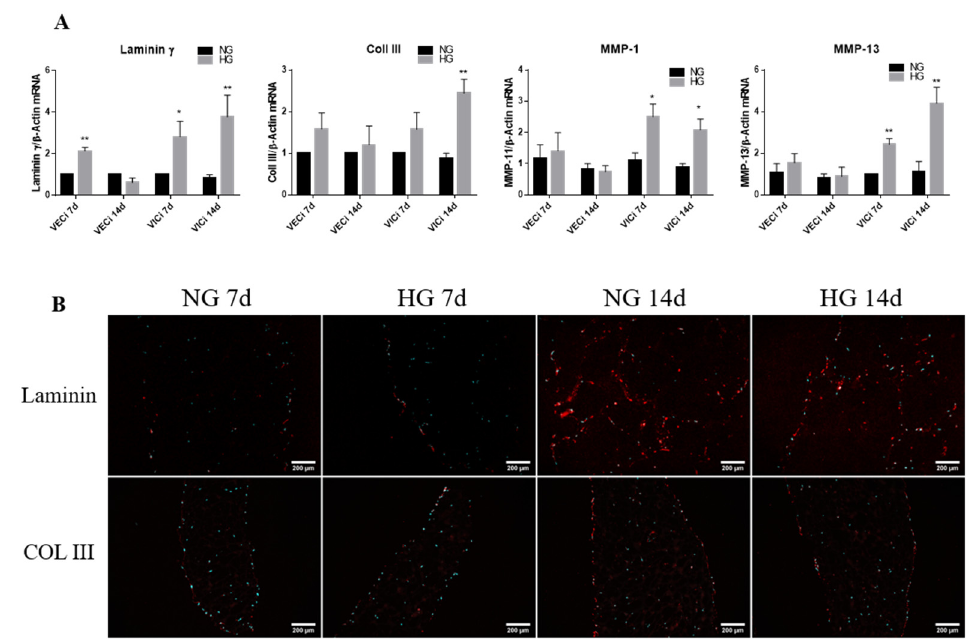
Figure 6. ( A ) Gene expression of extracellular matrix (ECM) proteins and MMPs (MMP-1 and MMP-13) in VEC and VIC cultured in 3D in HG versus NG glucose exposure, as evaluated by real-time PCR. The mRNA of investigated molecules was normalized to actin mRNA. The results are presented as fold change versus NG condition for every type of cell and investigated time. N = 3, * p < 0.5, ** p < 0.01. ( B ) Identification of ECM protein in 3D constructs with VEC and VIC, grown in NG or HG for 7 and 14 days. Representative images of laminin α 4 chain and collagen III in sections obtained from 3D constructs grown in NG and HG for 7 and 14 days. The images were taken with an 10× objective, with filter for DAPI (nuclei–cyan) and filter Alexa 594 (laminin and collagen III–red). Polymers 2020 , 12 , x FOR PEER REVIEW 11 of 15